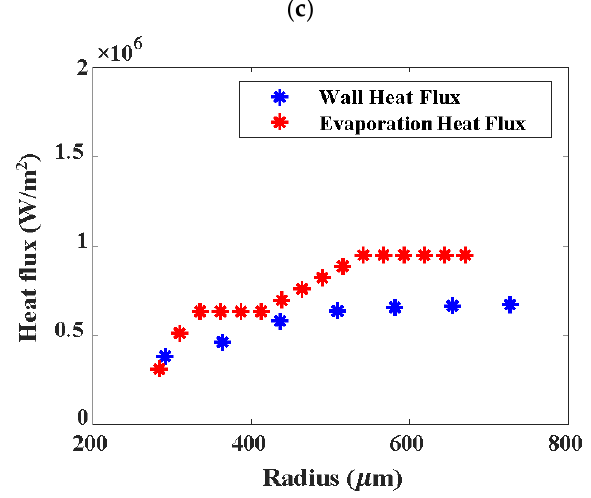
Figure 3. Radius evolutions of microlayer film thickness ( a ), variable wall temperature ( b ), and calculations of heat flux using two different methods ( c ). The black arrow in Figure 3a shows the temporal displacement for a constant film thickness. For brevity, heat flux data at only 3.9 ms is shown here. Please refer to [33–35] for additional details.